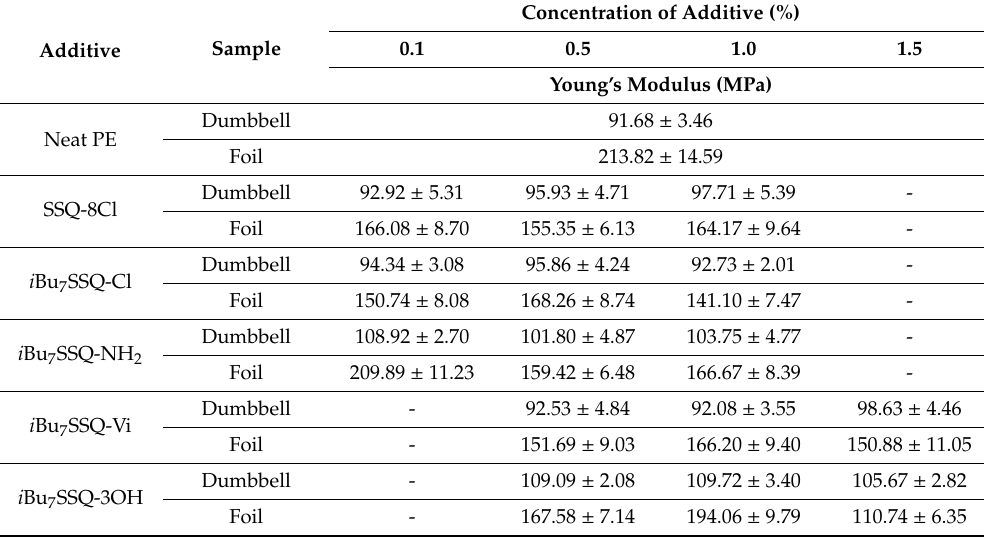
Table 2. Young’s modulus of the SSQ / PE